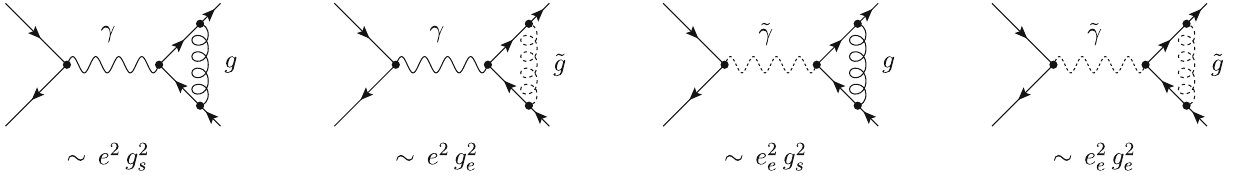
Fig. 3 Virtual diagrams for e + e − → γ ∗ → q ¯ q including a gluon g or an (cid:3) -scalar ˜ g . In cdr and hv , only the first diagram contributes, whereas in fdh also the second diagram is present. In dred , all diagrams